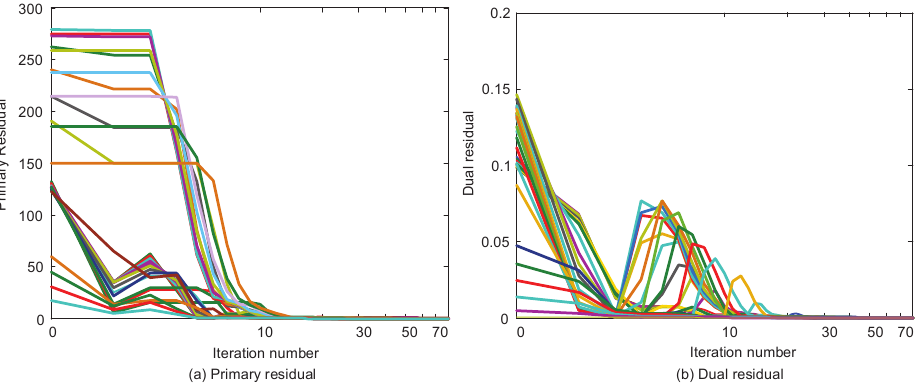
Figure 12. Iterative process of the primal residual and dual residual on Day 1 of Scenario 1 (( a ) Primary residual; ( b ) Dual